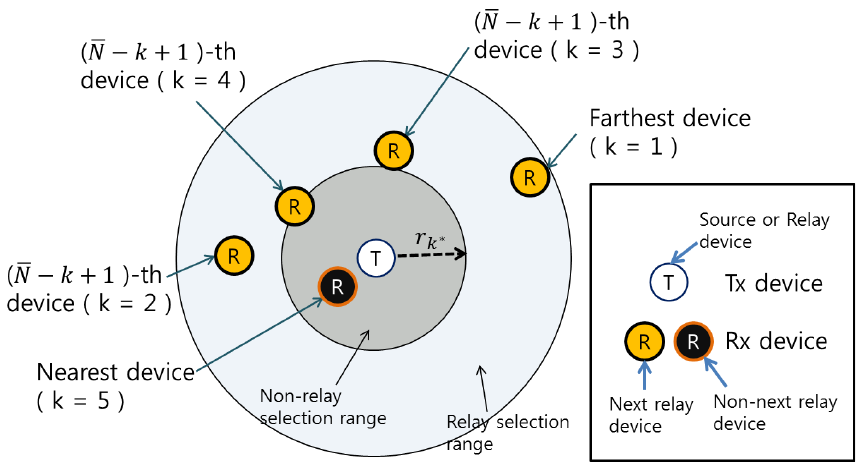
Figure 1. Relay selection with the n -th nearest distance when k = 4 and ¯ N =